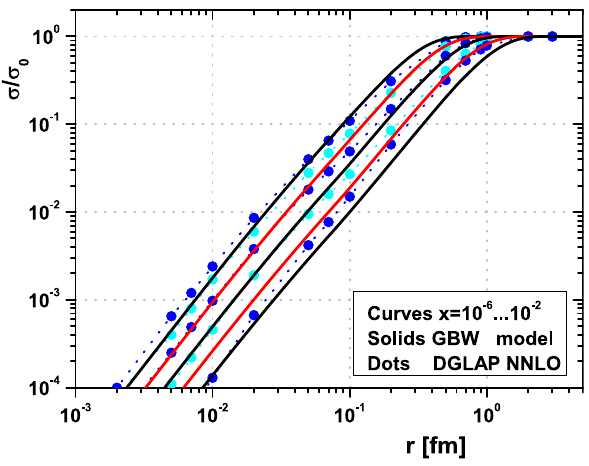
Fig. 2 The same as Fig. 1 within the NLO approximation